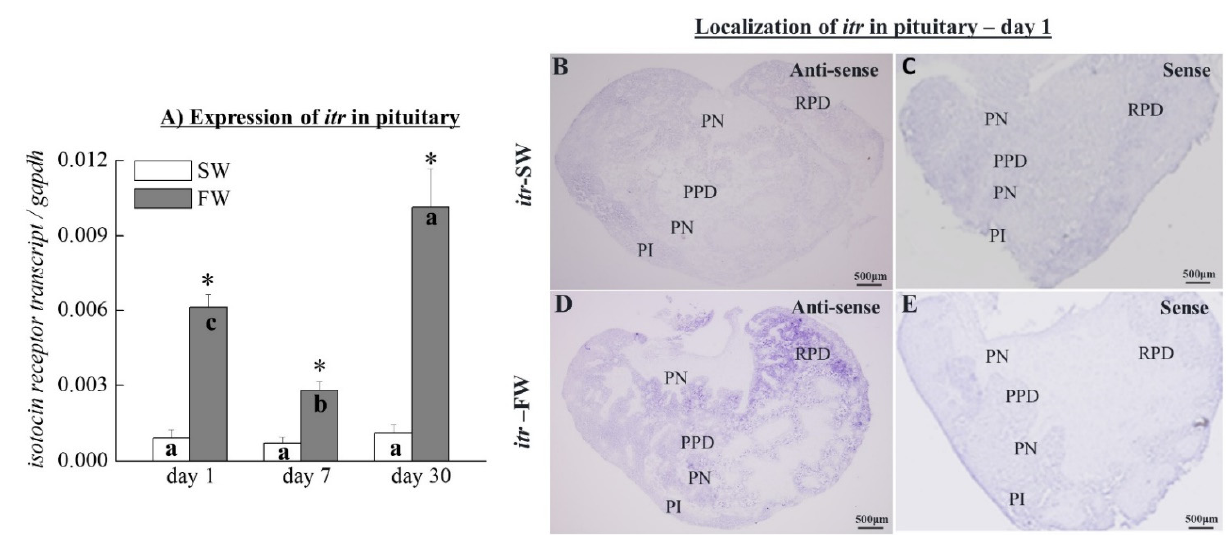
Figure 7. ( A ) Q-PCR analyzed the transcripts of itr ( A ) in the pituitary glands of SW and FW black porgies on day 1, day 7, and day 30 ( n = 8, in each group). Gene expression was normalized to the control ( gapdh ) gene. The results are expressed as mean ± SEM. Different letters indicate a significant difference between sampling points with the same treatment; asterisks (*) show differences between groups at the same time point (two-way ANOVA followed by Tukey’s test, p < 0.05). ( B – E ) The localization study of itr transcripts ( n = 4 in each group; revealed them in the pituitary glands of the SW ( B ) and FW ( D ) black porgies on day 1. There were no signals detected in the SW and FW fish when using the respective control sense probes of itr on day 1 ( C , E ). RPD: rostral pars distalis; PPD: proximal pars distalis; aNH: anterior neurohypophysis; pNH: posterior neurohypophysis.